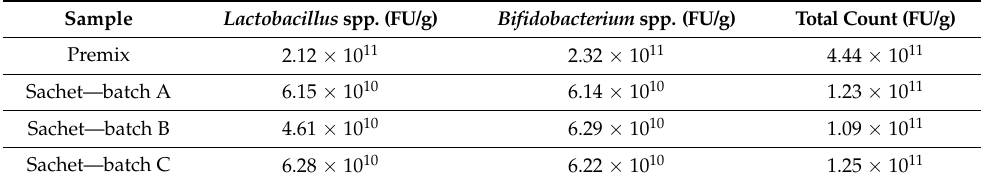
Table 5. Probiotic counts of food supplement 1 obtained by flow cytometry. Table 6. Probiotic counts of food supplement 2 obtained by flow cytometry.